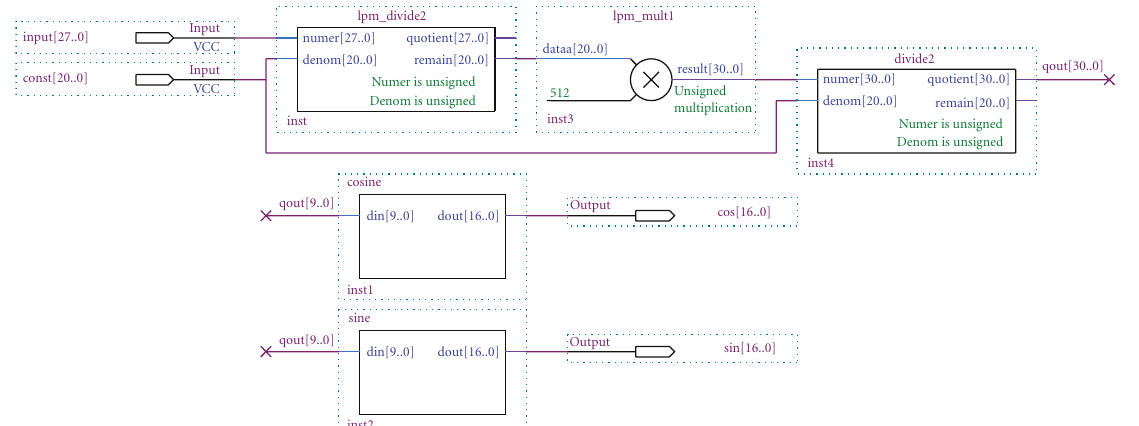
Figure 19: FPGA realization of cosine and sine function (cos and sin